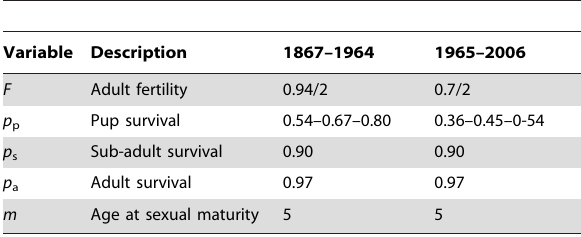
Table 1. Vital rates for Caspian seals during the